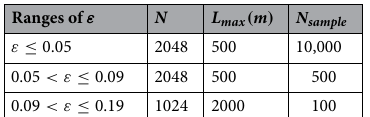
Table 1. Parameters of numerical simulations of